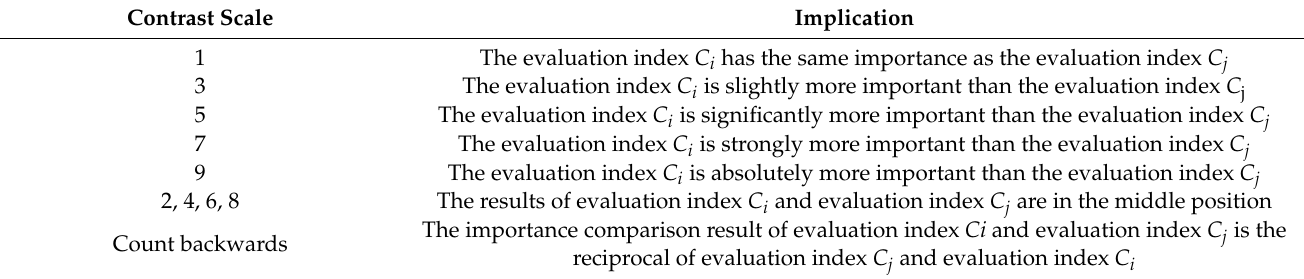
Table A1. Saaty’s contrast